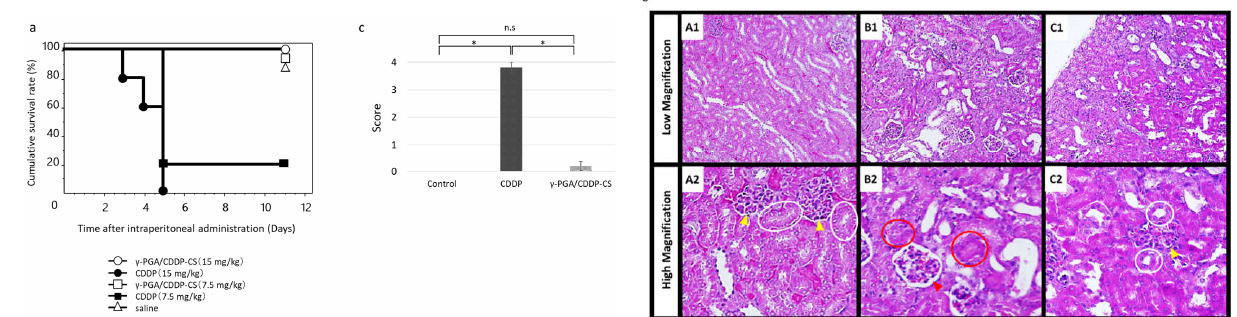
Figure 5. Acute toxicity after CDDP or γ−PGA/CDDP−CS administration. ( a ) The survival rate after CDDP (7.5, 15 mg/kg) and γ−PGA/CDDP−CS (7.5, 15 mg/kg) administration. The symbols represent the following: CDDP 15 mg/kg group (●), CDDP 7.5 mg/kg group ( ■ ), and γ−PGA/CDDP−CS group (15 mg/kg [ ◯ ], 7.5 mg/kg [□]). Differences between the groups in the survival experiment were determined using the Kaplan–Meier log−rank test. The mean survival time of mice that received treatment with each γ−PGA/CDDP−CS was significantly prolonged compared with that of mice treated with each free CDDP. Respectively, the differences between γ−PGA/CDDP−CS vs. CDDP, 15 vs. 7.5, 7.5 vs. 7.5, 15 vs. 15, and 7.5 vs. 15 mg/kg were considered statistically significant at p < 0.05, p < 0.05, p < 0.005, and p < 0.005. ( b ) The hematoxylin and eosin stained image of murine kidney shows no damage or damage to the proximal renal tubule in the saline group (A1: Low magnification; A2: High magnification) and the CDDP (4.5 mg/kg) group (B1: Low magnification; B2: High magnifi- cation). The white and red circles show a normal and damaged proximal renal tubule, respectively, while the yellow and red arrowheads show a normal and damaged Bowman’s capsule, respectively. No injury was observed in the control and γ−PGA/CDDP−CS (45 mg/kg) groups (C1: Low magnification; C2: High magnification). ( c ) Histological changes due to tubular necrosis were quantitated by determining the percentage of tubules with evident cell necrosis and tubule dilata- tion. Data are represented as mean values ± standard error of the mean (SEM). Statistical analysis was performed using the Mann–Whitney test, with the significance level at a p −value of <0.05 (*). 3.5. Antitumor Efficacy in a Murine Malignant Pleural Mesothelioma Model All mice in the high−dose and 80% in the low−dose CDDP groups had died by Day 14 after tumor cell implantation (Day 5 after drug administration). In the control group, the nodule diameter increased over time. In the high−dose γ−PGA/CDDP−CS group, a transient increase in the nodule diameter was suppressed in a dose−dependent manner from Days 13 to 15. However, in the low−dose group, the nodule diameter was similar to that in the control group (Figure 6).